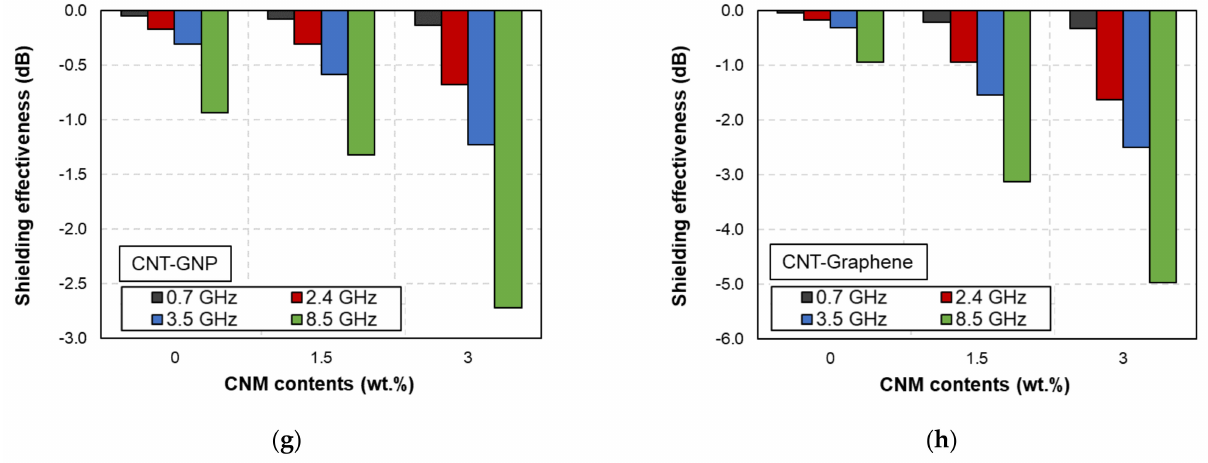
Figure 6. Effects of different CNM types on EMI shielding effectiveness of ( a – d ) CFRP- and ( e – h ) GFRP-based